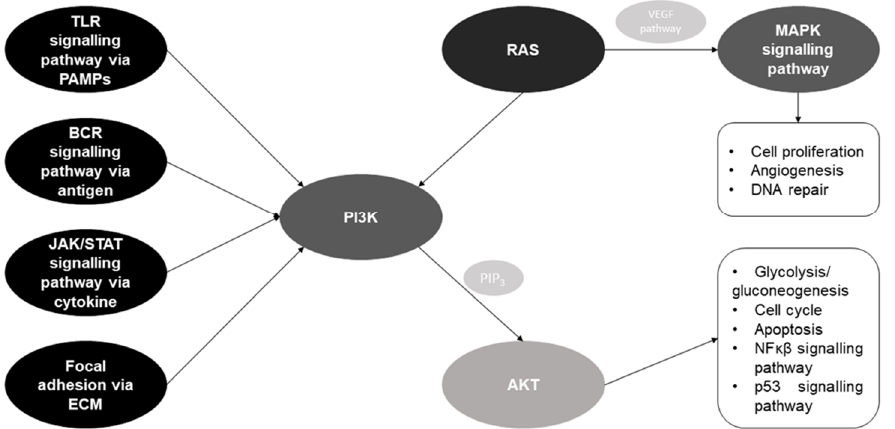
Figure 3. A general schematic diagram illustrating the directional links between signalling pathways containing target genes for miRNAs differentiating selected respiratory diseases. Black fields represent pathways directly or indirectly impacting the PI3K or MAPK pathway. Light grey fields are intermediate particles (PIP3) or pathways (VEGF). The box lists the processes influenced by selected pathways. Abbreviations: TLR, Toll-like receptor; PAMPs, pathogen-associated molecular patterns; BCR, B cell receptor; ECM, extracellular matrix; PIP3, phosphatidylinositol-3,4,5-triphos- phate.